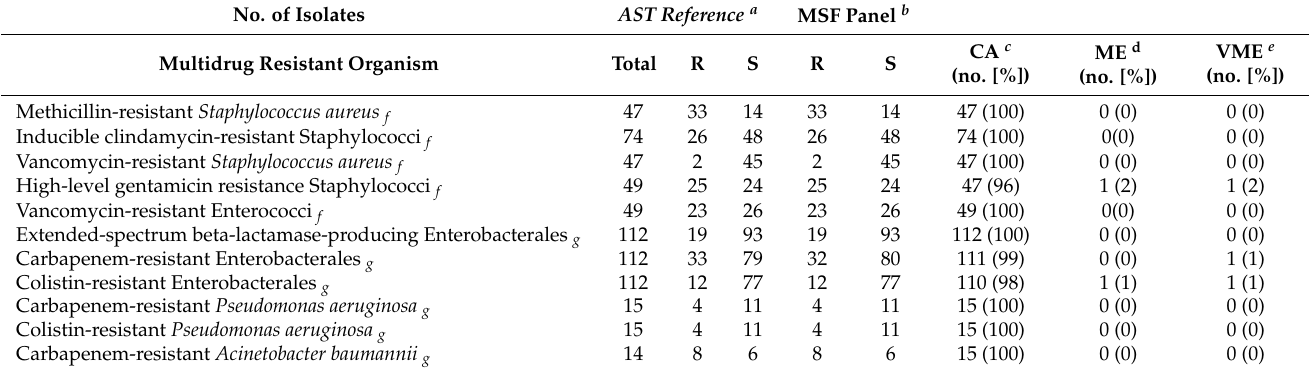
Table 8. Results for specific resistance tests using MICNEG1 or MICPOS1 standard turbidity inoculum methods and visual reading versus AST reference